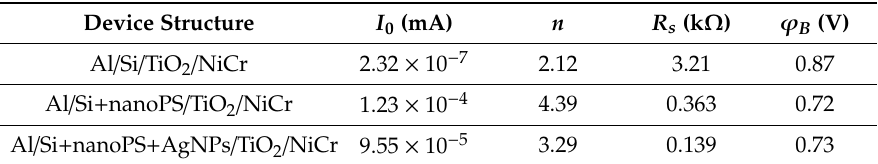
Table 4. DC electrical parameters obtained from the fitting of the experimental I - V curves. Device